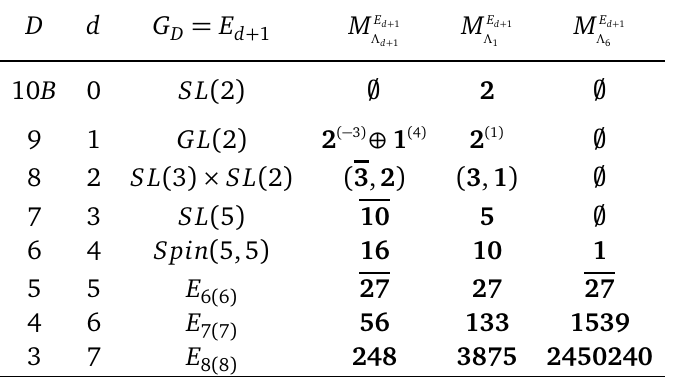
) and string multiplet ( Λ ); the d + 1 1 and Λ , 1 6